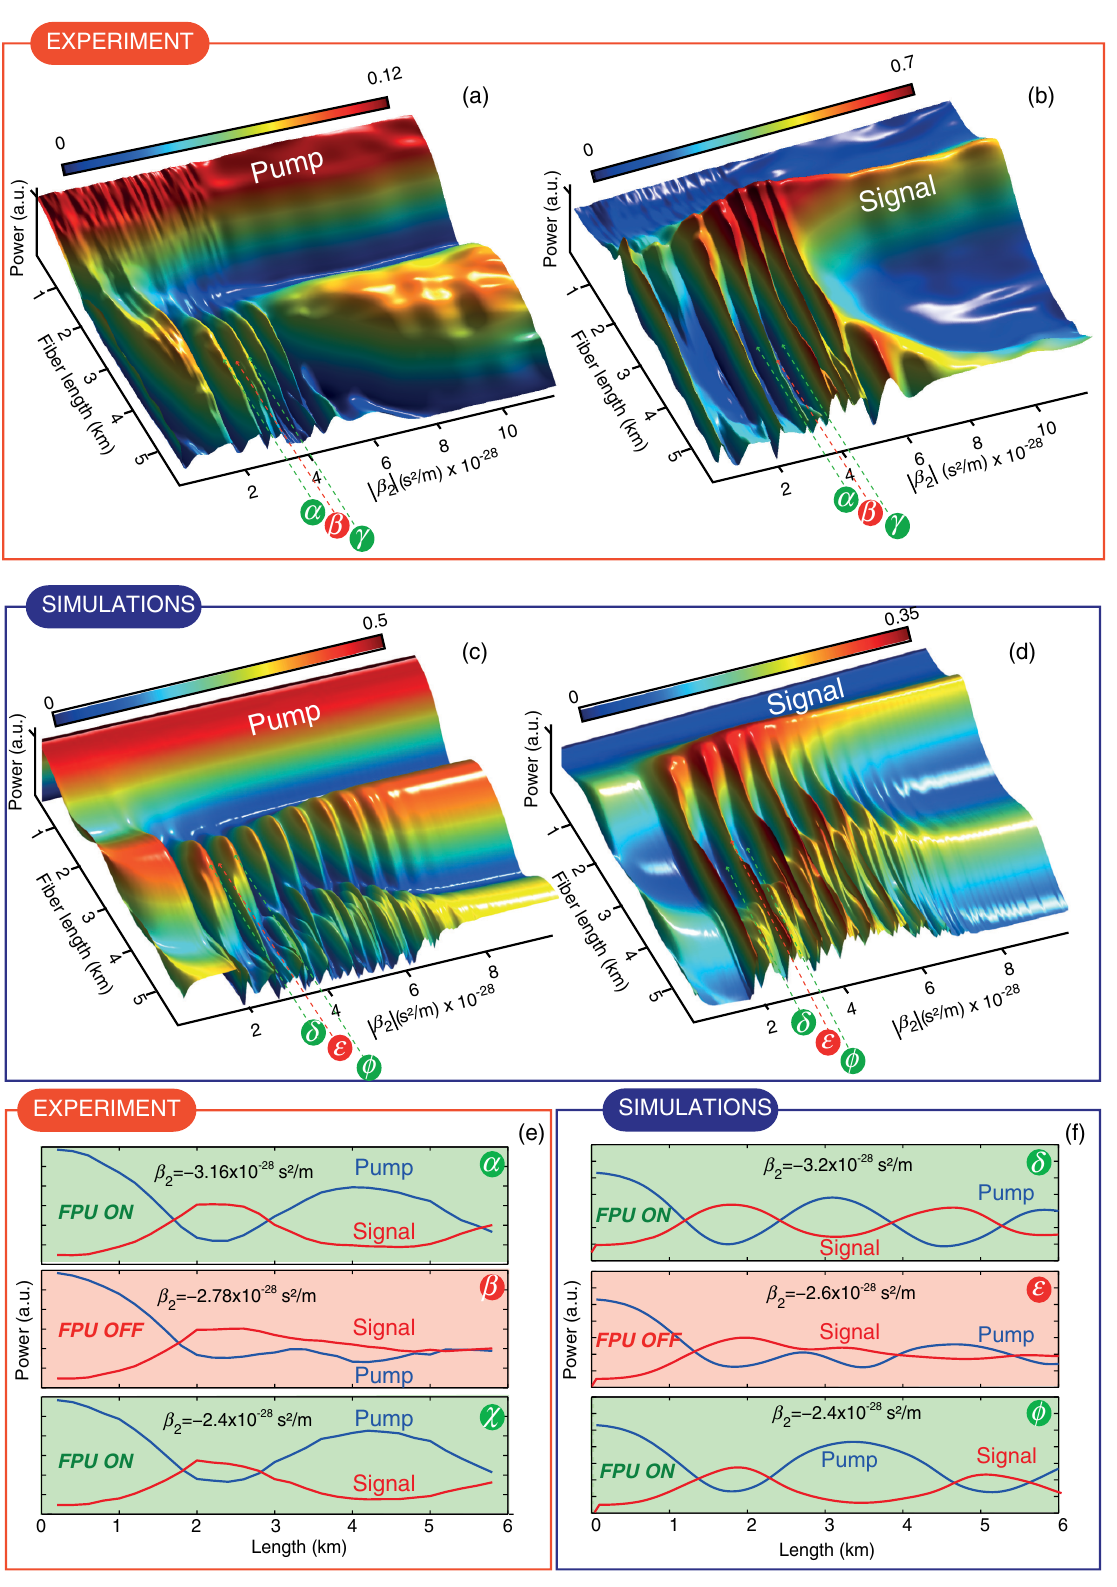
FIG. 2 Plot of the pump and the signal power versus j β 2 j and the fiber length, (a) and (b) in experiments and (c) and (d) in simulations. (e) and (f) show their evolution at specific j β 2 j values for which the FPU recurrence is observed or canceled, in experiments and simulations,